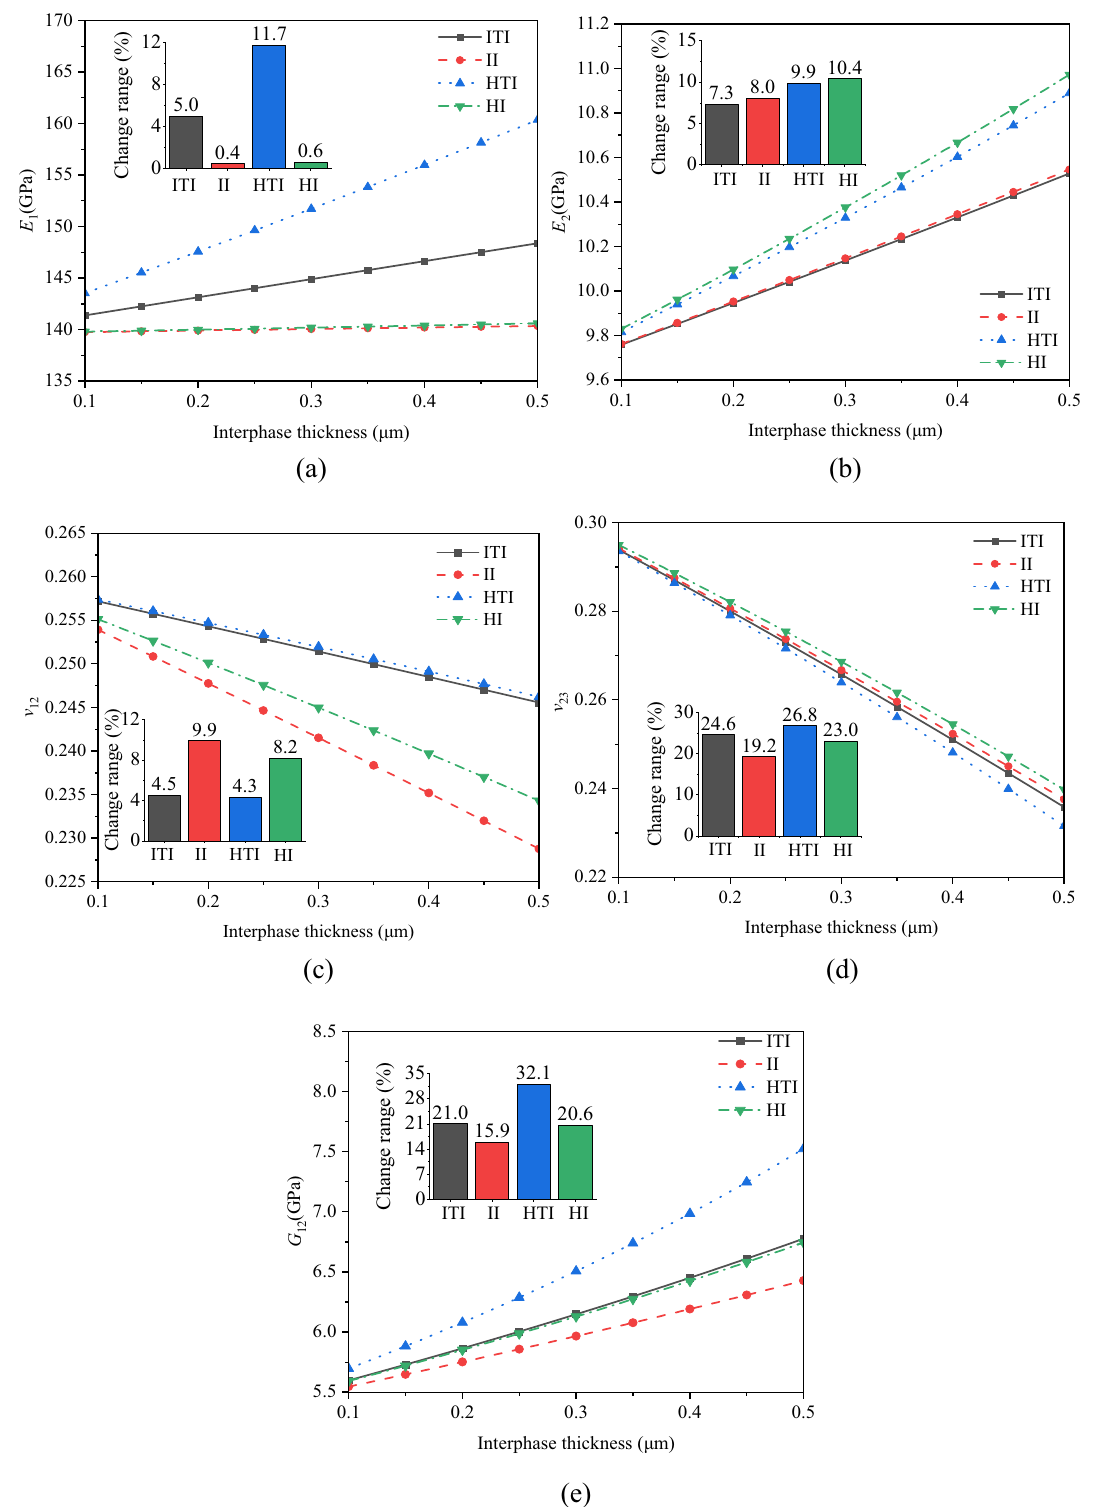
Figure 11: E ff ect of interphase thickness on the composite elastic property with di ff erent interphase types: ( a ) elastic modulus E 1 , ( b ) elastic modulus E 2 , ( c ) Poisson ’ s ratio ν 12 , ( d ) Poisson ’ s ratio ν 23 and ( e ) shear modulus G 12